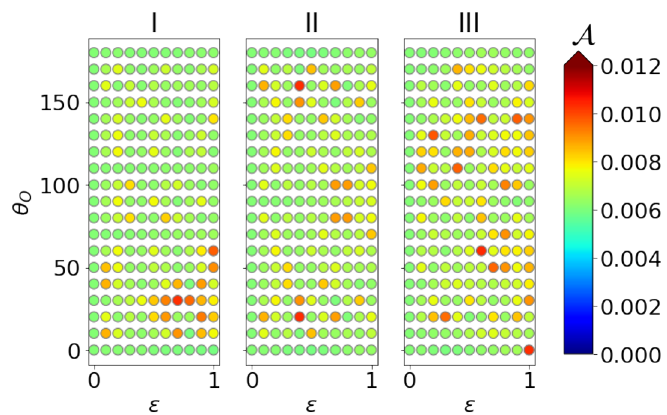
Figure 7 . Shape asymmetry A (indicated by the color bar) of the shadows for the three types of soft hair functions given in (4.8)–(4.10) with the size parameter E tuned between 0 and 1 , and for different observer’s inclination angles. Within the error introduced by the finite resolution about 0 . 012 M , there is no obvious shape asymmetry. This is some kind of observational manifest of no-hair theorem even in the presence of soft